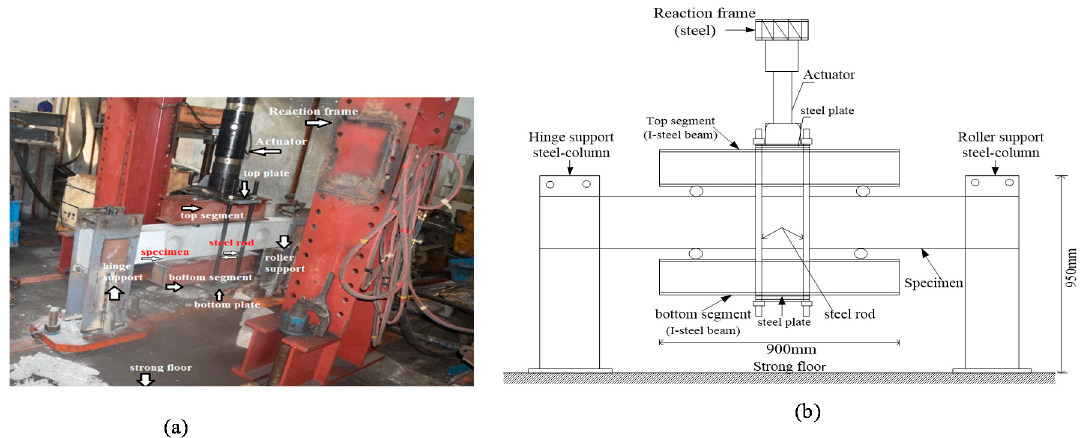
Figure 3. Experimental setup of tested beams: ( a ) photograph of test setup for BC-2. Note: the other beams were similar to that shown. ( b ) Schematic test setup for all beams.